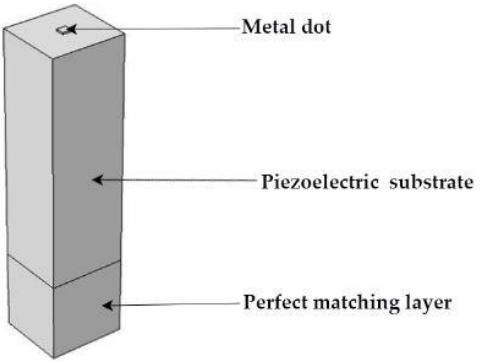
Figure 4. A 3D model of the single-period structure. Table 1. Material parameters used in FEM simulations